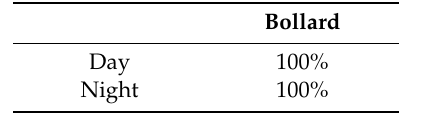
Table 4. Accuracy measurement for bollard location